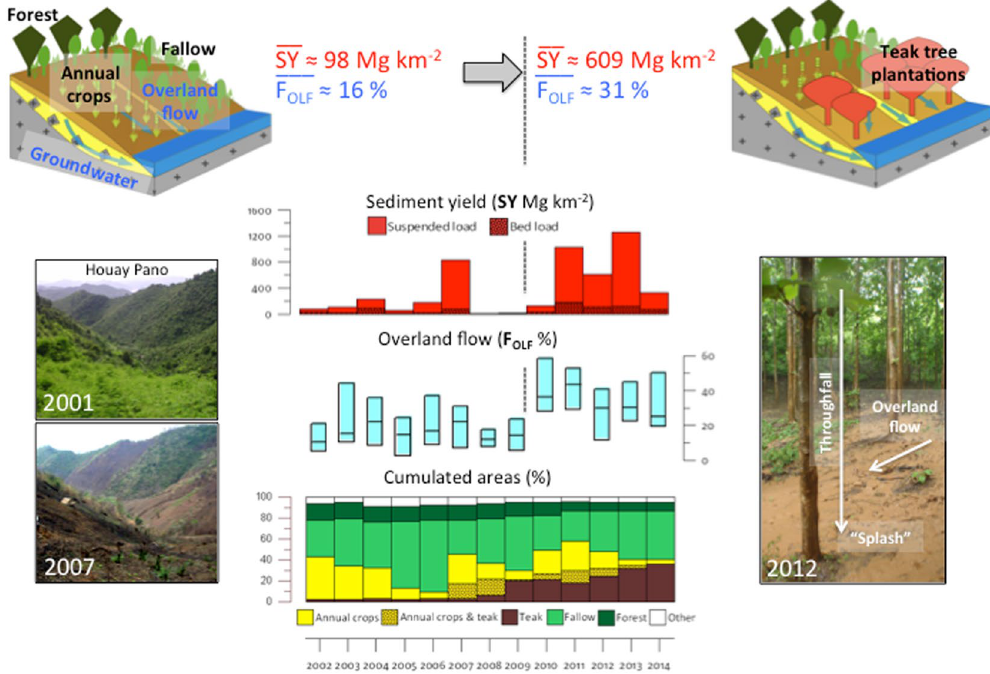
Figure 7. Graphical abstract: bottom left side, two pictures of the Houay Pano catchment in 2001 (almost entirely covered by fallow) and 2007 (after burning and before cropping); bottom right side, a picture of overland flow in a teak tree plantation during a rainfall event; centre, the figure shows plots of measurements conducted at the S4 monitoring station: annual sediment yield (SY) including suspended load and bed load contributions, box plots of overland flow contribution (F OLF ) during flood events, and areal percentages of the catchment covered by the main land uses; top left and right, conceptual diagrams of the extreme land use situations observed in the catchment; top centre: inter-annual median values of SY and F OLF for the two periods 2002–2009 (left) and 2010–2014